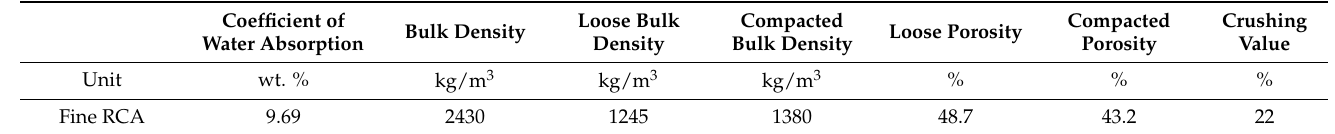
Table 4. Water absorption, bulk density, porosity, and crushing test of fine RCA.